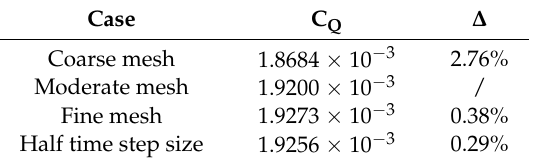
Figure 5. Rotor torque coefficient obtained with three resolution grids and half time step size. Table 4. Value and relative error of the torque coefficient (C Q ) at the final steady state.